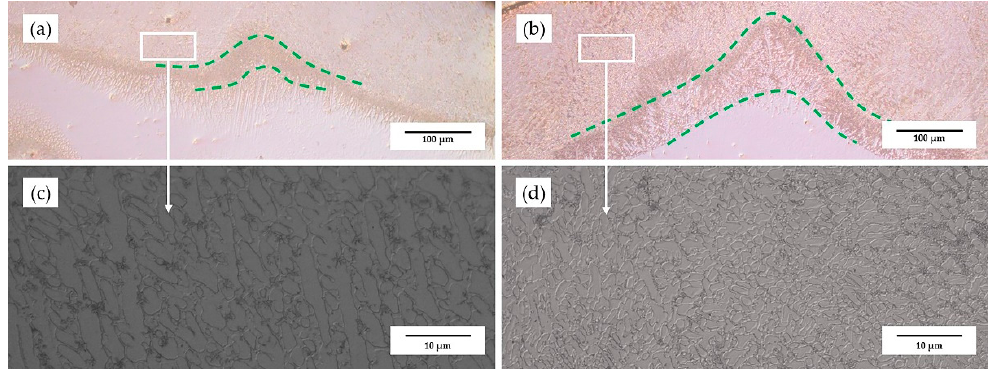
Figure 7. Microstructure of the bottom area in the cladding layer: ( a , c ) 55NiTi coating; ( b , d ) 55NiTi + 5Ni coating.